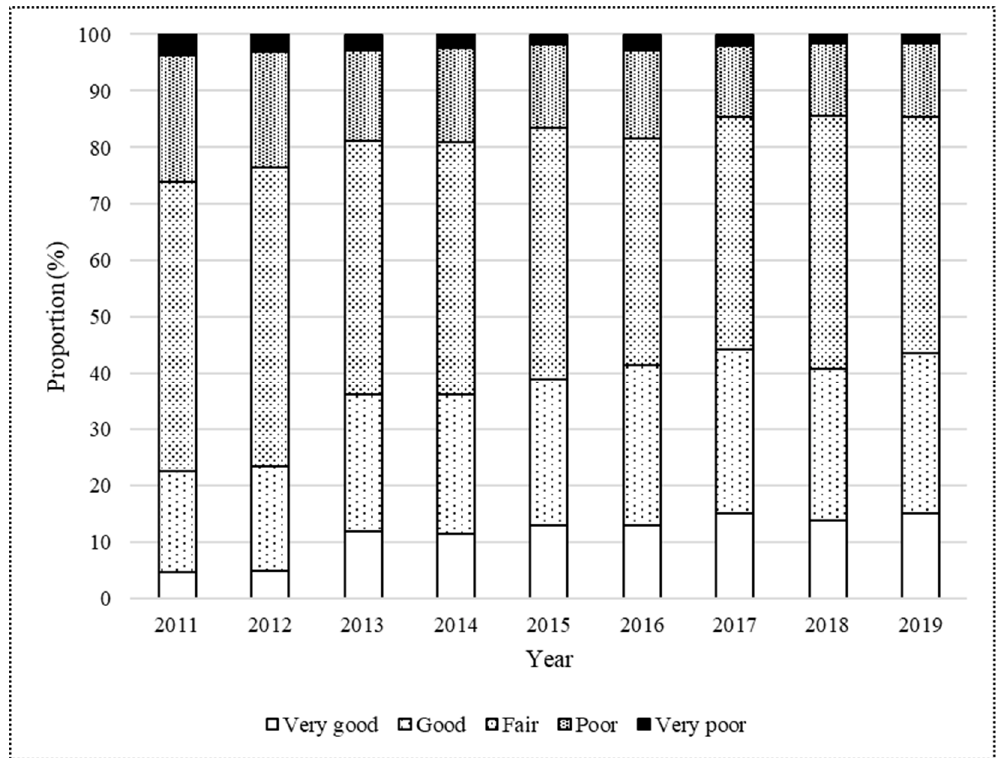
Figure 1. Self-rated oral health status of Japanese university students from 2011 to 2019.